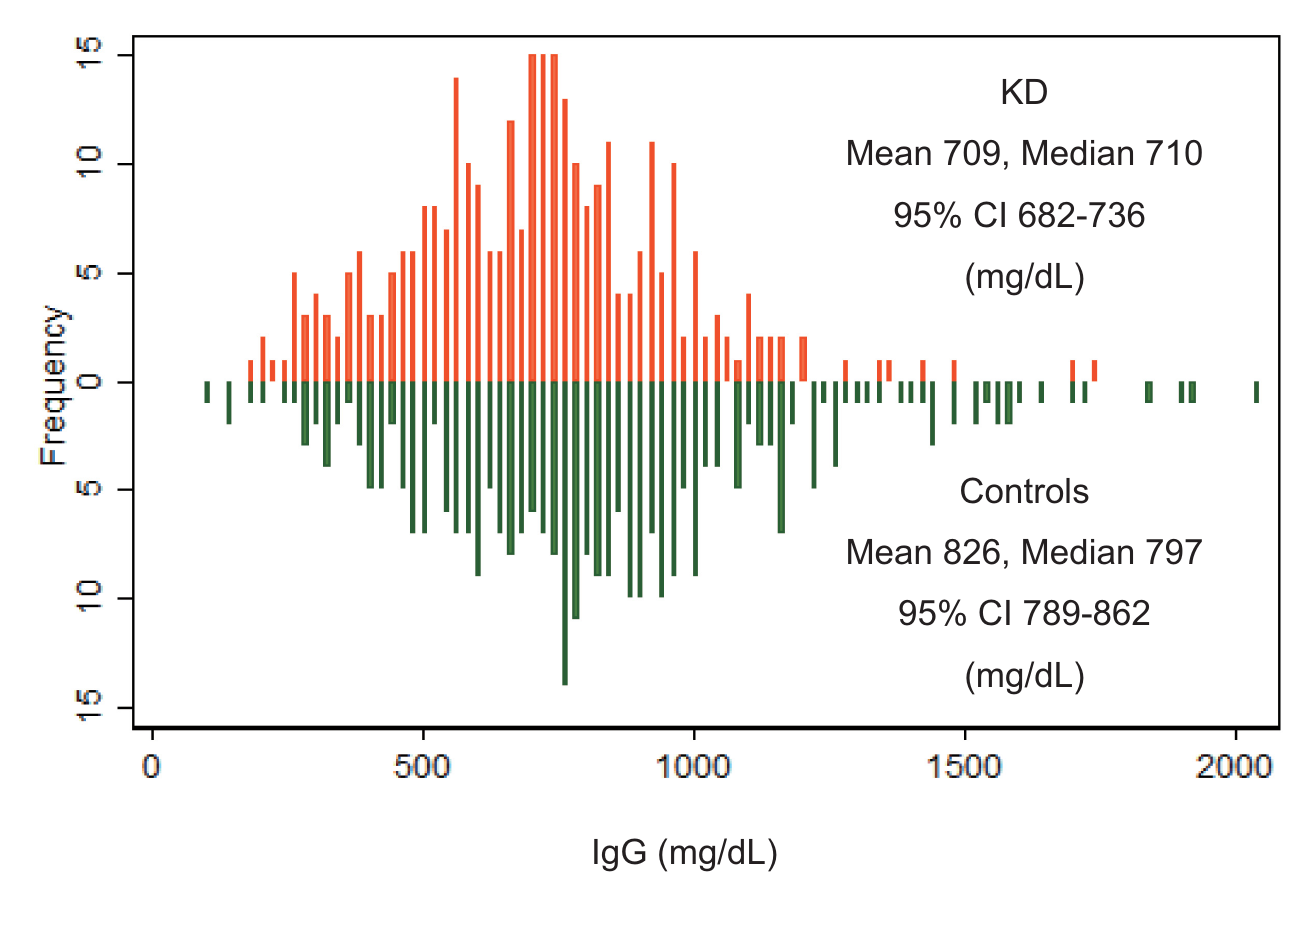
Fig 6. IgG distributions of patients with KD and matched control individuals. Patients with KD were selected from the pre-COVID period (2010–2019). Each control individual was matched to a patient with KD in terms of sex, age, and date of IgG testing. IgG values in patients with KD were significantly lower than those in control